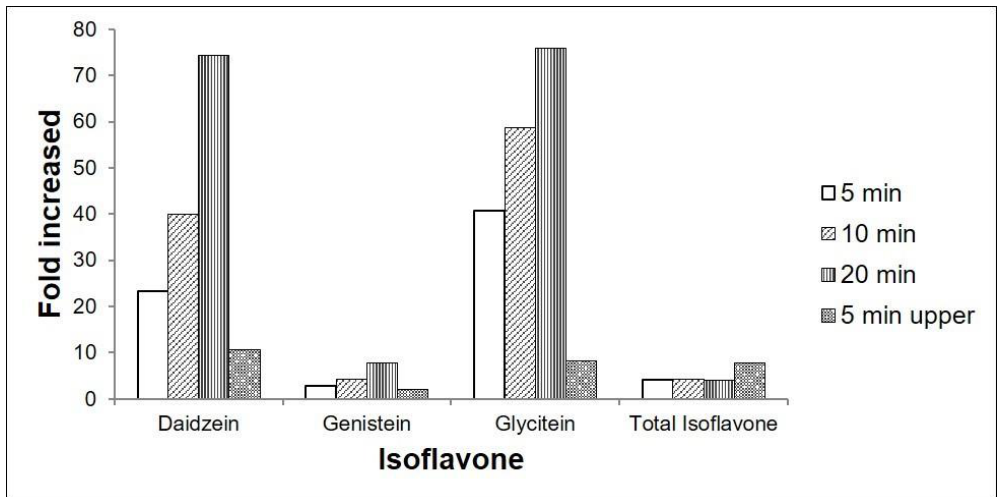
Figure 6. Approximate fold increase in aglycone compounds (daidzein, genistein, and glycitein) and total isoflavone concentration in G. max cv. Daepung after UV-C irradiation. Bars represent the fold increase after UV-C treatment for di ff erent time periods compared to that of the control.